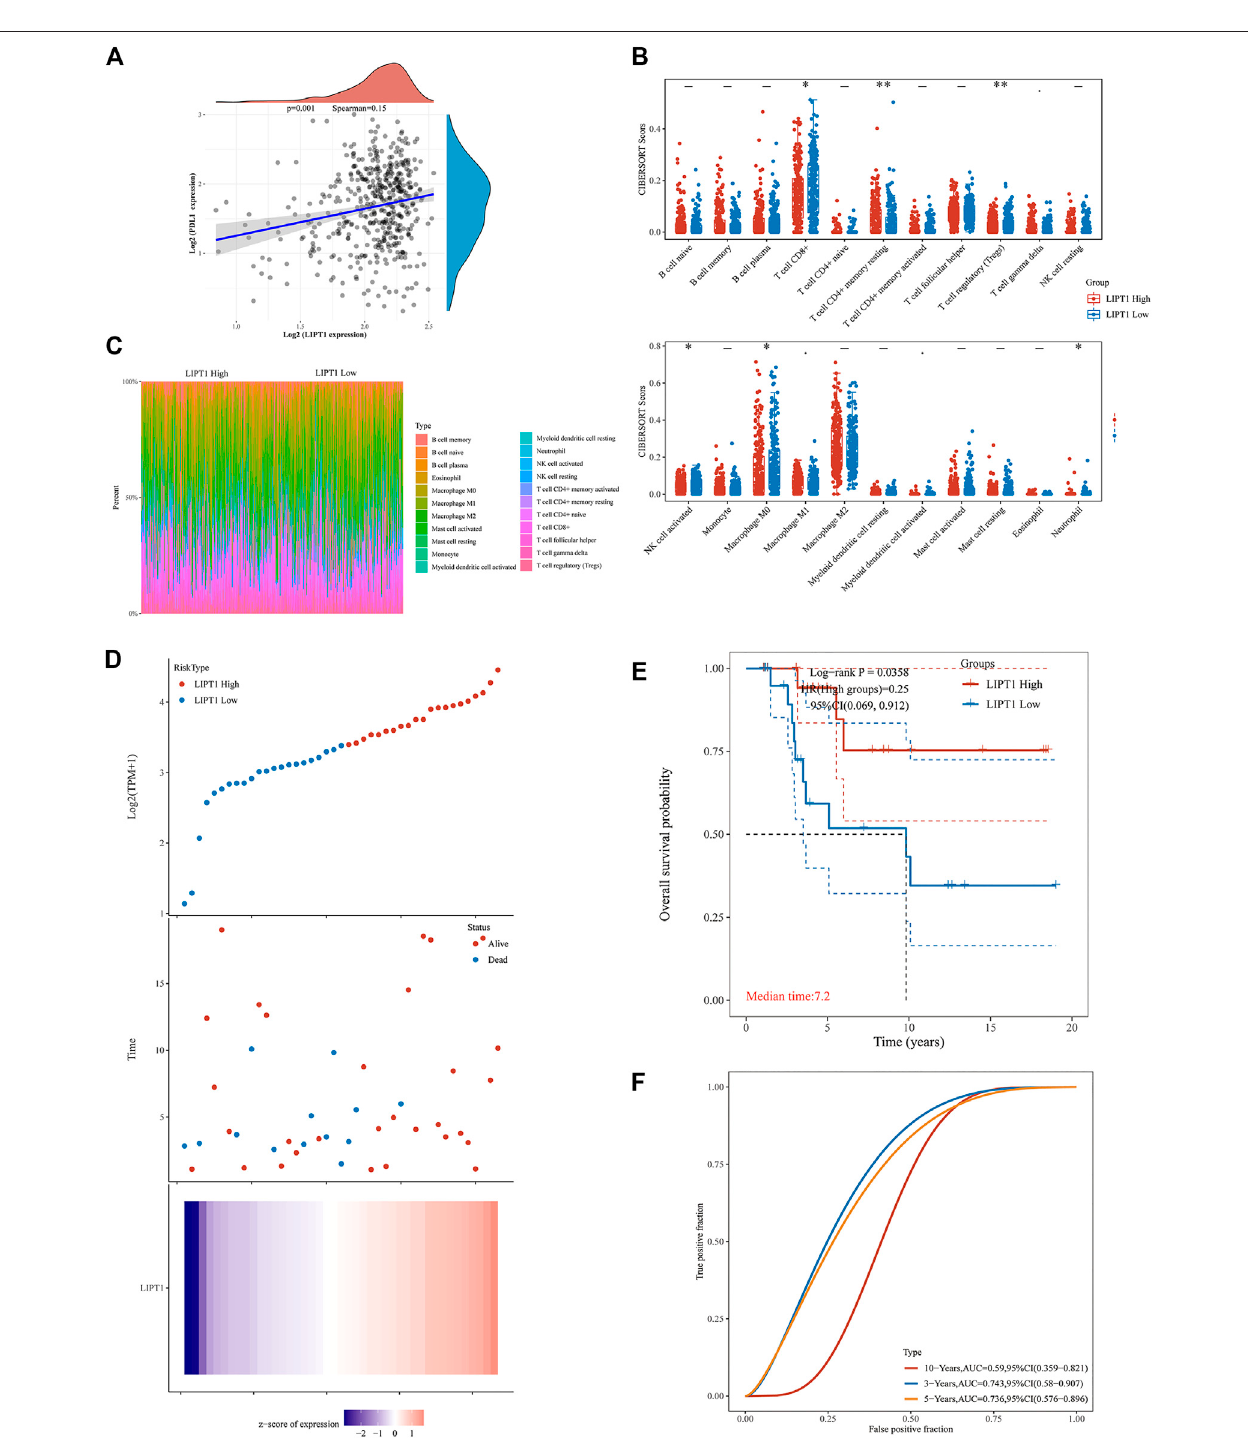
FIGURE5| RelationshipbetweenLIPT1expression,immunotherapyandin fi ltratingimmunecellsinSkinCutaneousMelanoma(SKCM)bycorrelationanalysis. (A) Thecorrelation analysisofPD-L1expressionandLIPT1expressioninSKCM. (B) Thein fi ltratinglevelsofimmunecellsinhighandlowLIPT1expressiongroupsinSKCM patients. (C) The percentage abundance of tumor-in fi ltrating immune cells showed the immune in fi ltration analysis between high and low LIPT1 expression groups in SKCM patients. (D) The gene expression, survival time, and survival status of the TCGA database. (E) Kaplan-Meier survival analysis of the gene signature from TCGA cohort. (F) The ROC curve of